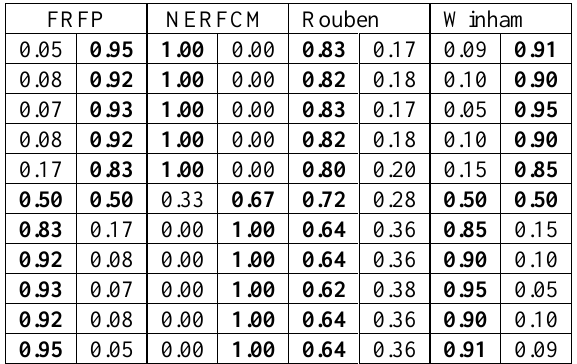
Table 2 Membership matrices for the 5 methods for a two cluster partition ( rows correspond to objects) for proximity matrix 1